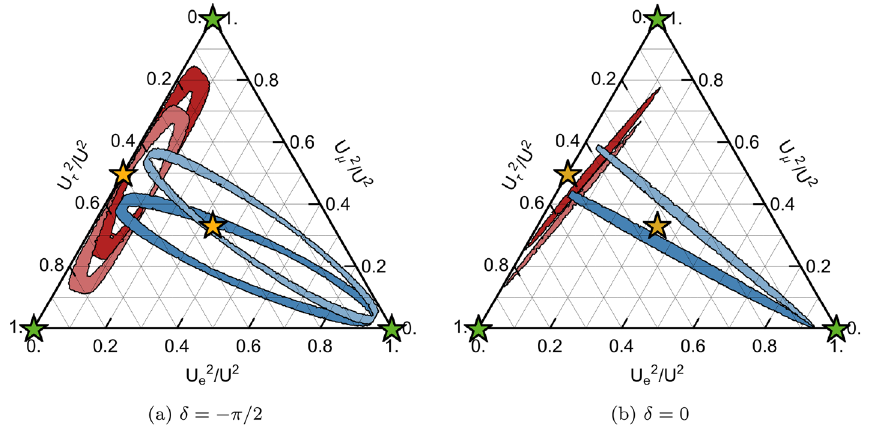
≡ sin 2 θ = 0 . 58 (darker region) and s 2 = 0 . 42 (lighter angle s 2 23 23 23 region) that were used in the DUNE TDR [82]. Comparable sensitiv- ity can be expected at Hyper-K [83,84]. The remaining parameters are fixed to their current best fit values. Note that the projected regions are independent of